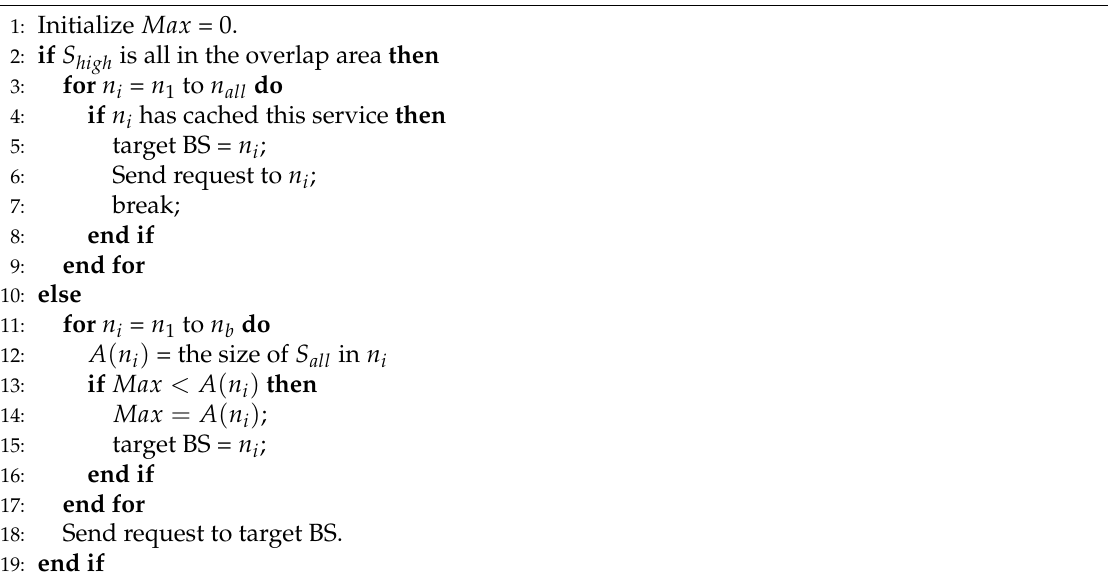
Algorithm 1 Service Allocation